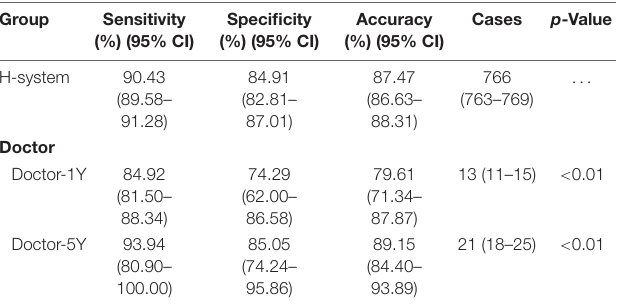
TABLE 3 | Comparison of time for handling with 60 cases and single case among H-system and doctors.